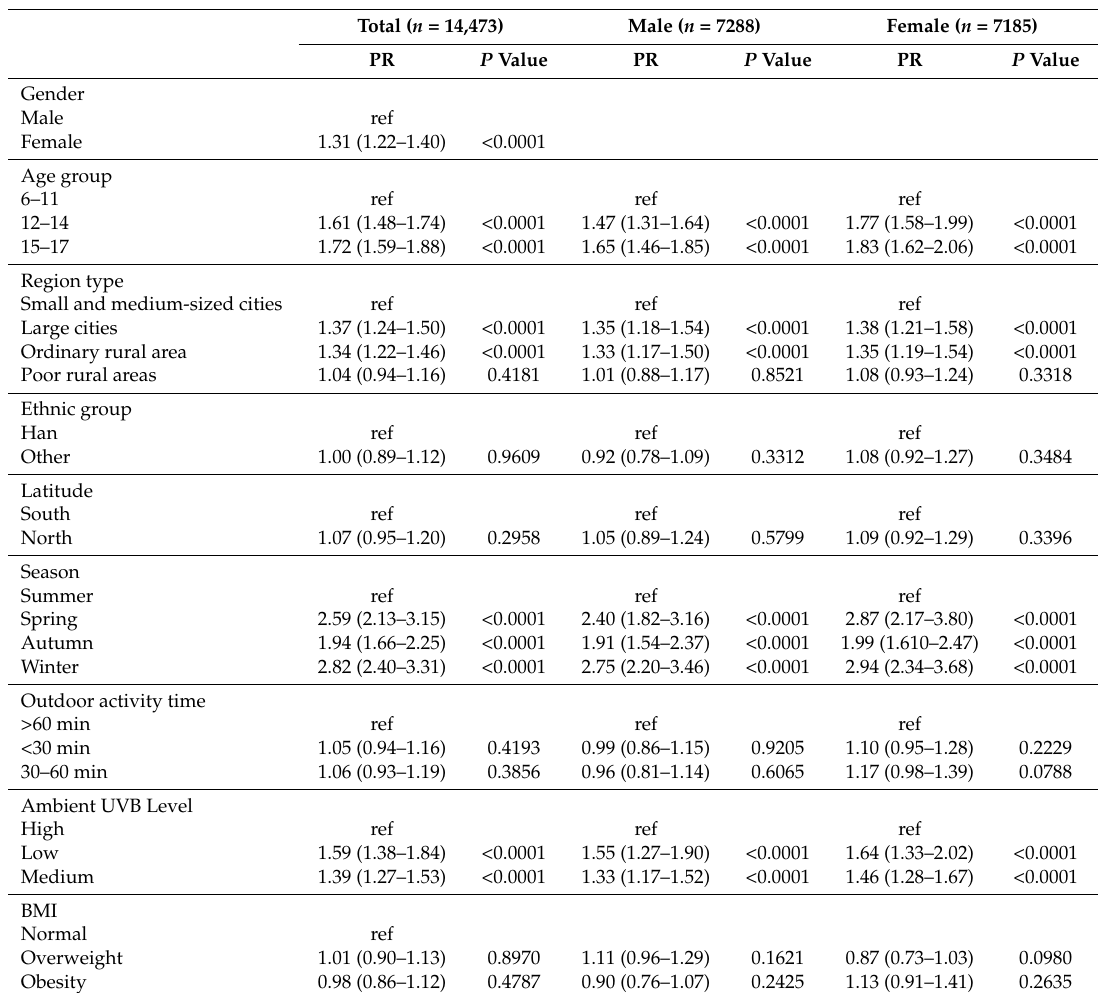
Table 3. Determinants of vitamin D deficiency among Chinese children and adolescents from the Chinese nutrition and health survey 2010–2012 1 (log-binomial